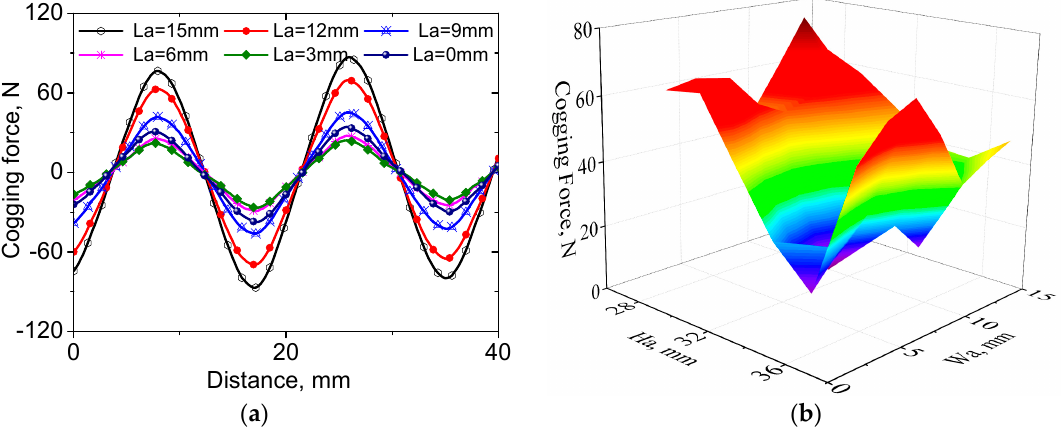
Figure 12. The cogging force optimization of MI-TLPMG with mutative geometric parameters: ( a ) varying La; ( b ) changing W a and H a synchronously.